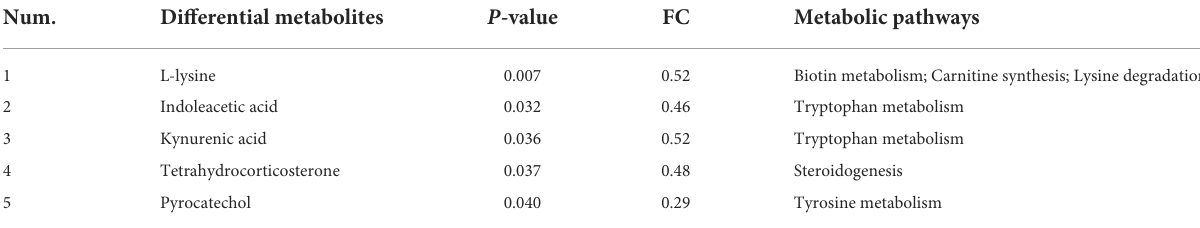
TABLE 7 Metabolic pathways for differential metabolites in the S3 compared with the S0.